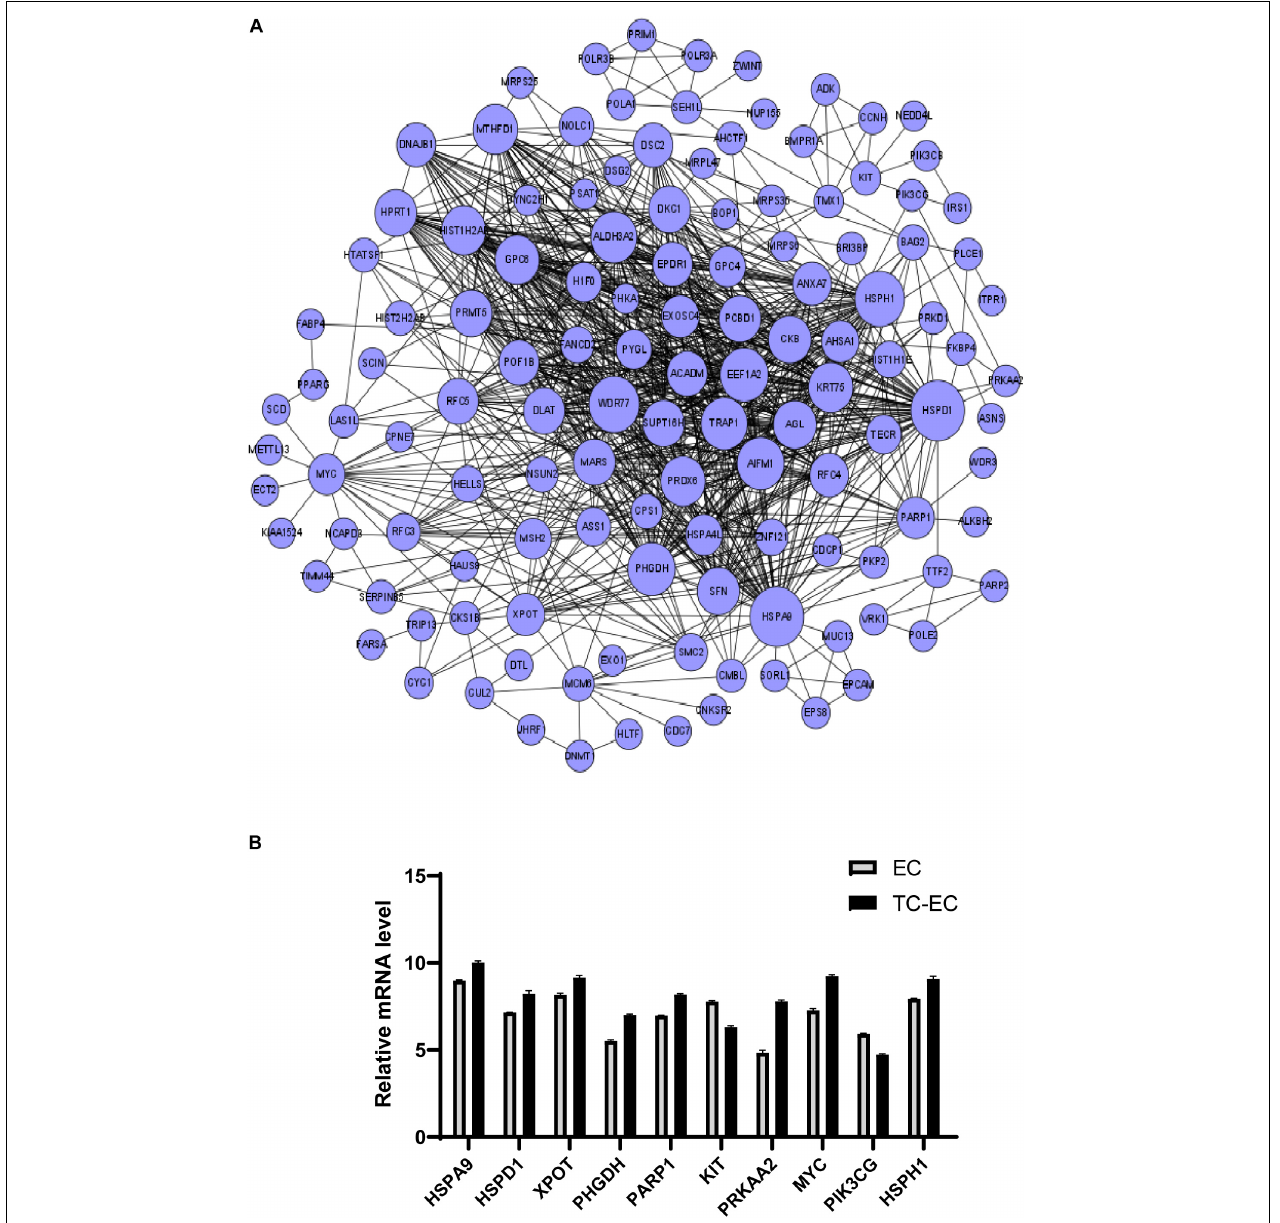
FIGURE 4 | Differential mRNA–mRNA interaction network. (A) The network graph of mRNA–mRNA interaction. The circle represents mRNA; the size of the circle represents the betweenness centrality value. The bigger the value, the more signal transmission is involved, indicating that the mRNA has greater ability to regulate mRNA interactions. (B) Expression level of the top 10 differential mRNAs between the TC–EC model and EC according to the differential mRNA–mRNA interaction network